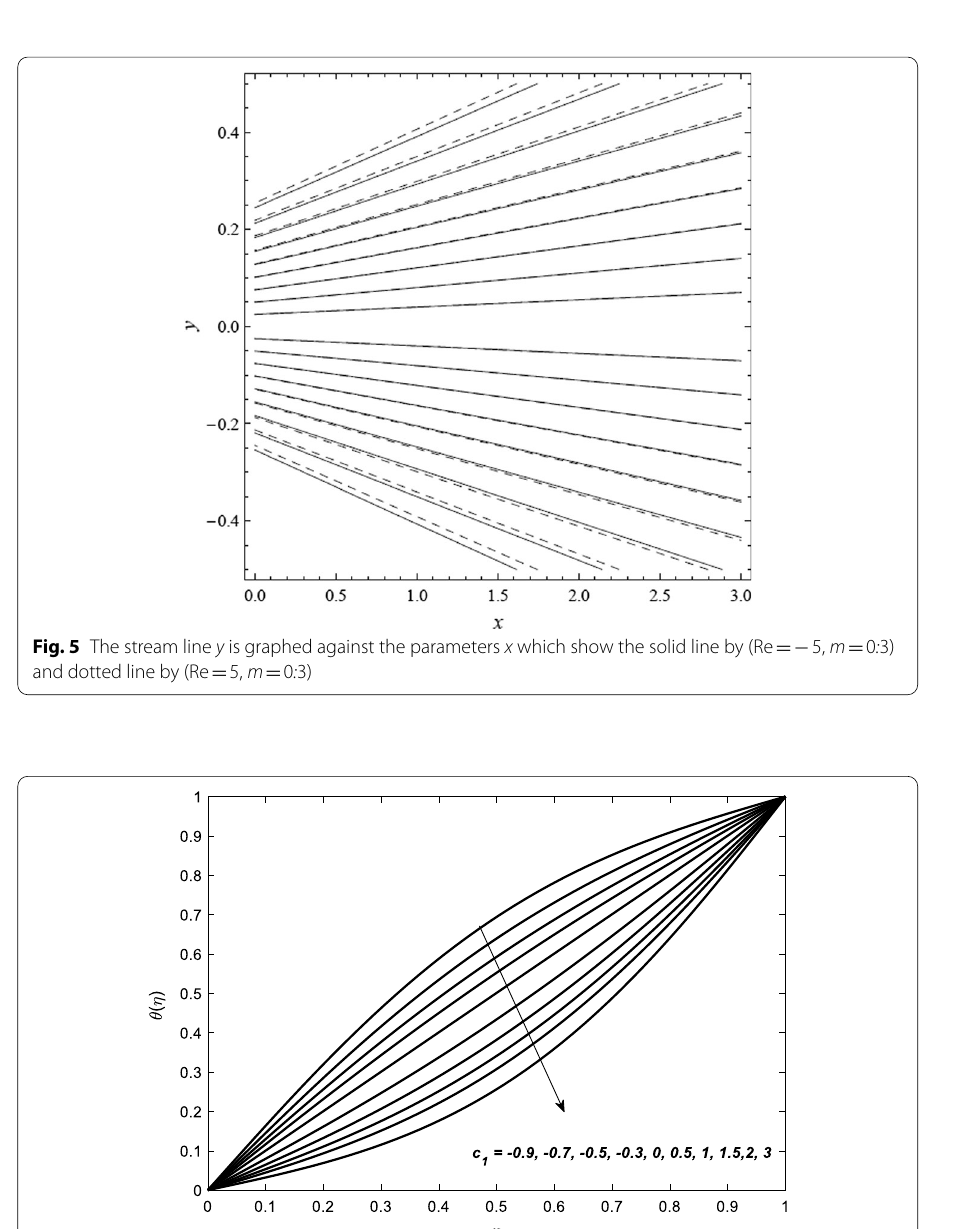
Fig. 6 θ is graphed against η for m